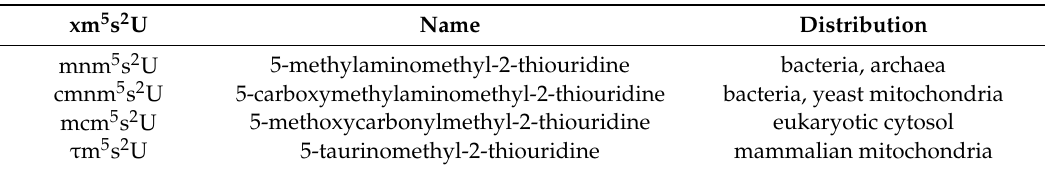
Table 1. Diversity and distribution of the s 2 U derivatives (xm 5 s 2 U) at position 34 of tRNA Gln UUG , tRNA Lys UUU , tRNA Glu UUC